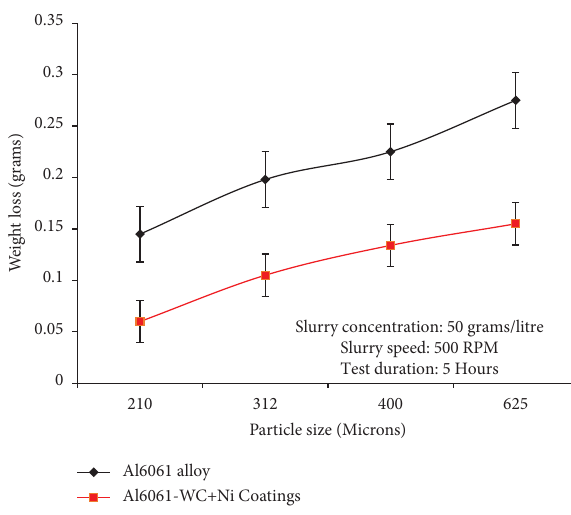
Figure 9: Infuence of particle size on slurry erosive